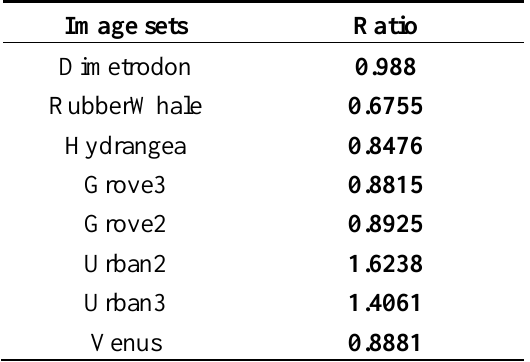
Table 7. Result for the second comparison step.